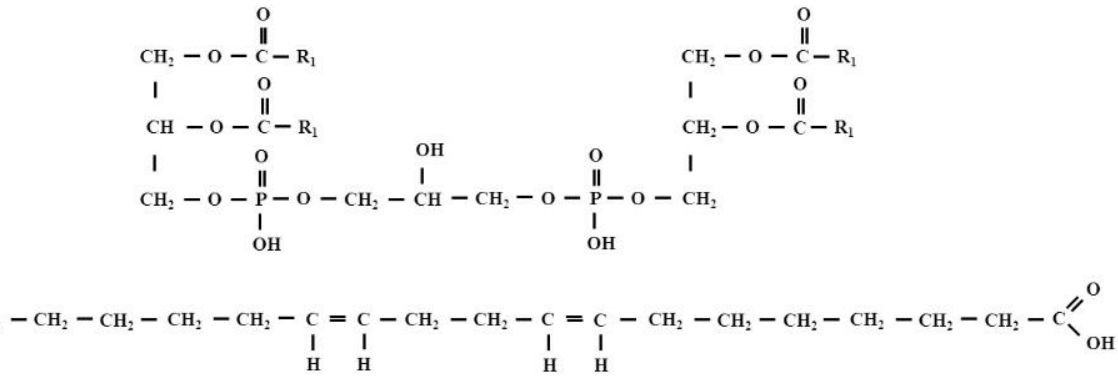
Figure 6. The structural formula of tetralinoleoyl cardiolipin (L 4